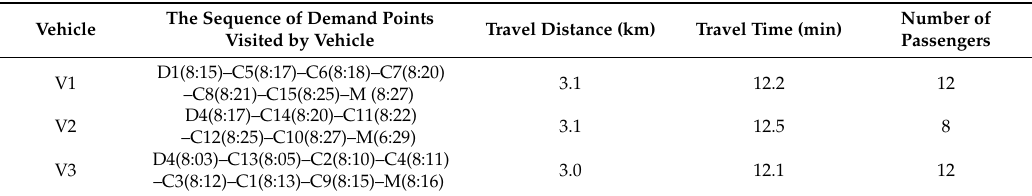
Table 4. Routing and scheduling plan of each vehicle.